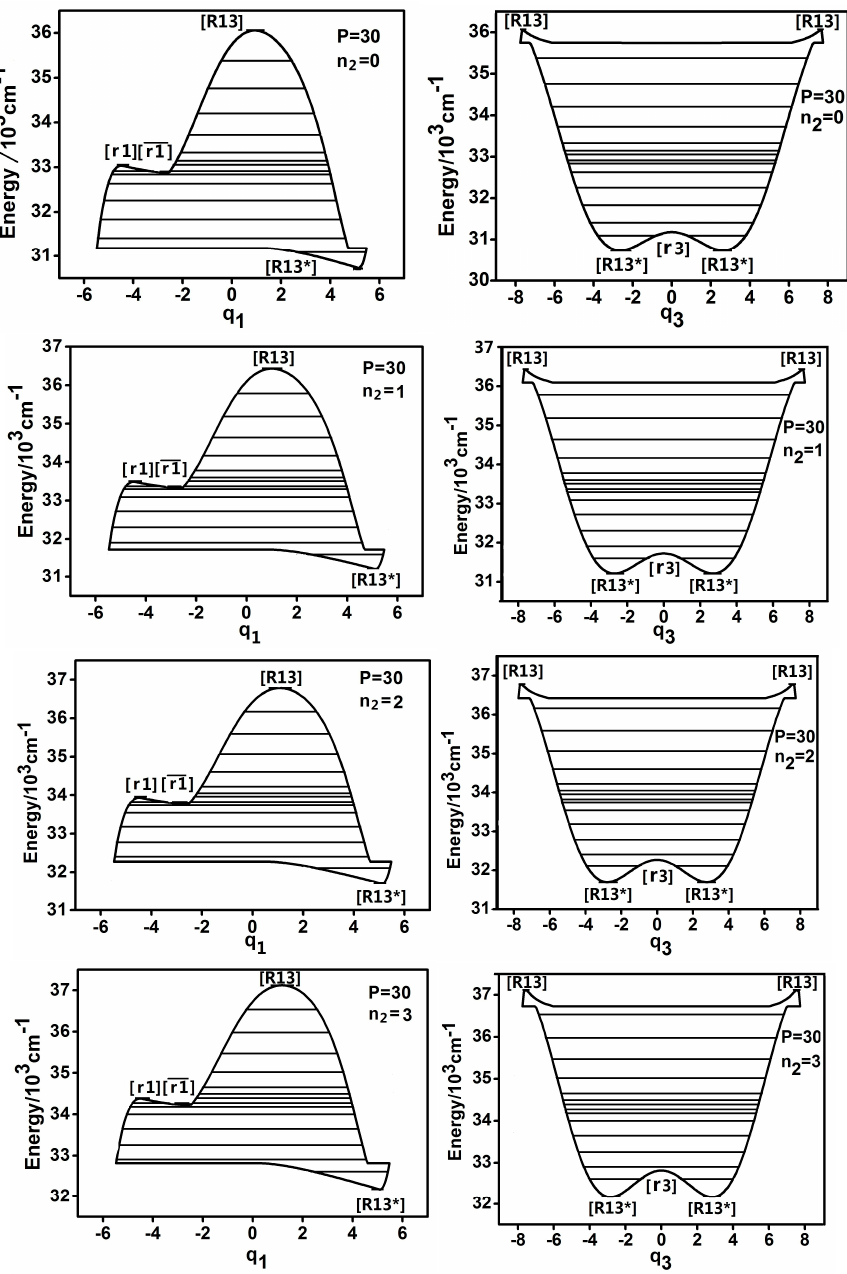
n = 0,1,2,3, and the energy levels included in the 2